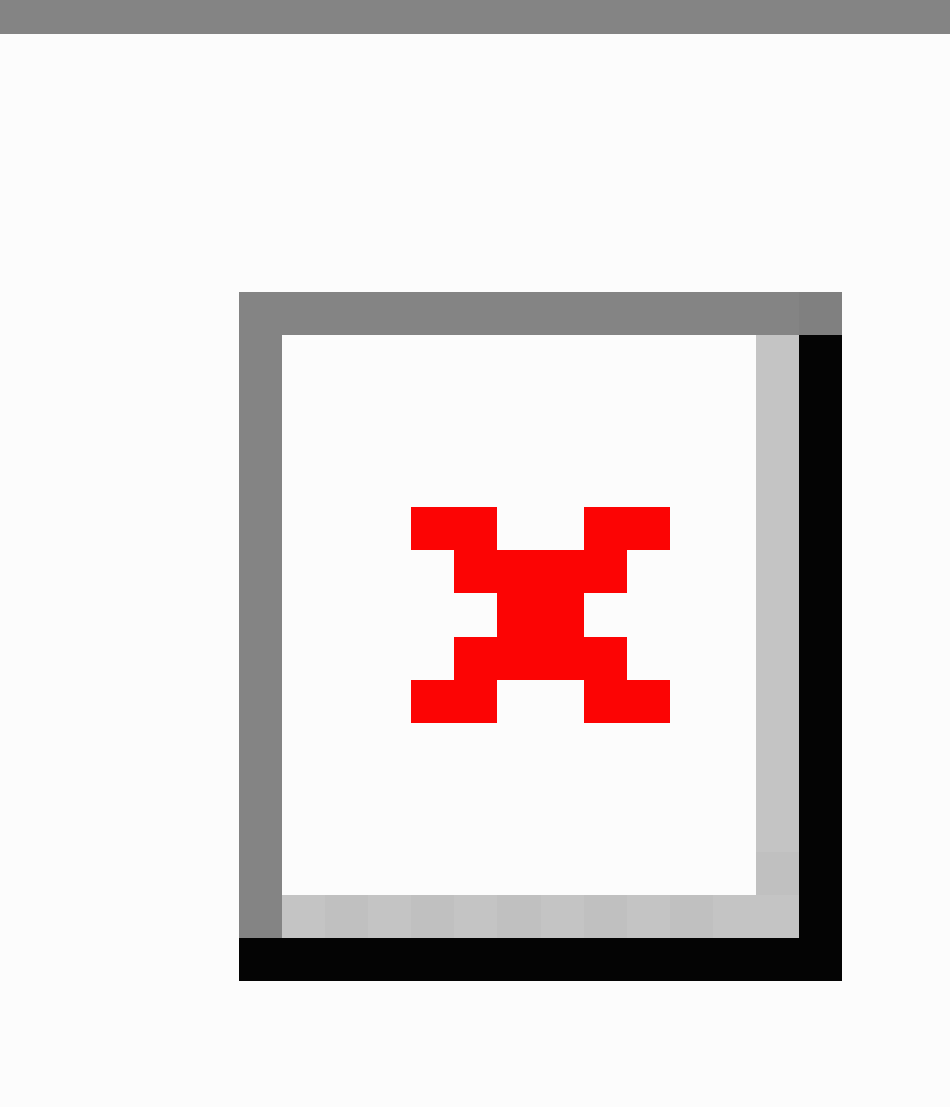
Figure 5. Pairwise post hoc comparisons using the Tukey HSD test showed a significant difference between patients diagnosed with a severe condition more than 2 years before the intervention and patients diagnosed during the intervention (mean difference in change 12.4, P =.02). The differences between the other groups were not statistically